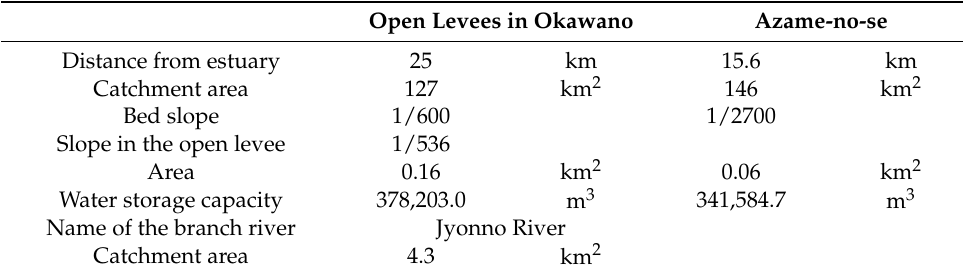
Table 3. Water Level Observatory [27].